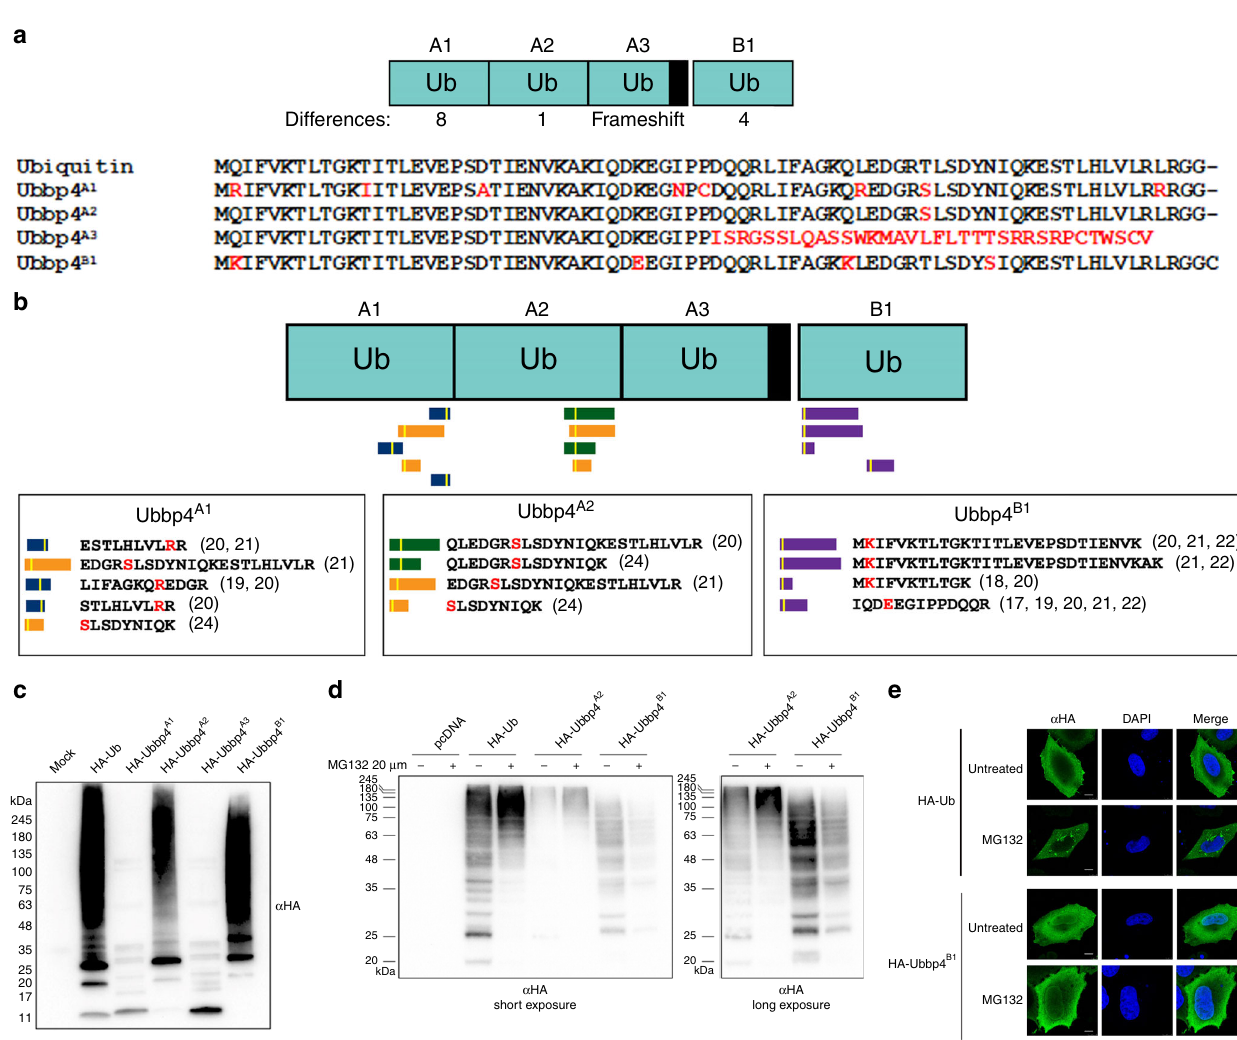
Fig. 2 UBBP4 encodes a functional ubiquitin variant without proteasomal targeting. a The UBBP4 gene encodes three ubiquitin repeats within a fi rst ORF, Ubbp4 A1 , Ubbp4 A2 , and Ubbp4 A3 , and a fourth ubiquitin within a second ORF, Ubbp4 B1 . The differences in amino acids compared with Ub are highlighted in red. b Identi fi cation of unique peptides in different large-scale proteomics experiments. The white bars in the peptides indicates the approximate position of the amino acids differences with the canonical Ub, and are shown in red. The unique peptides identi fi ed are shown with the reference to the datasets. c Total cell extracts of HeLa cells transfected with HA-tagged Ub, or Ubbp4 A1 , Ubbp4 A2 , Ubbp4 A3 , or Ubbp4 B1 were separated by SDS-PAGE and revealed with an HA antibody ( n = 3 biologically independent experiments). d HeLa cells were either untransfected, or transfected with plasmids expressing HA-tagged Ub or Ubbp4 A2 or Ubbp4 B1 , and treated or not with MG132. Total cell extracts were separated by SDS-PAGE, and proteins were revealed by immunoblotting with an HA antibody ( n = 3 biologically independent experiments). e HeLa cells transfected with either HA-Ub or HA-Ubbp4 B1 were treated or not with MG132 overnight and labeled for immuno fl uorescence microscopy with an HA antibody. The nuclei were stained with DAPI ( n = 3 biologically independent experiments). Scale bars indicate 10 µ m. Source data are provided as a Source Data fi